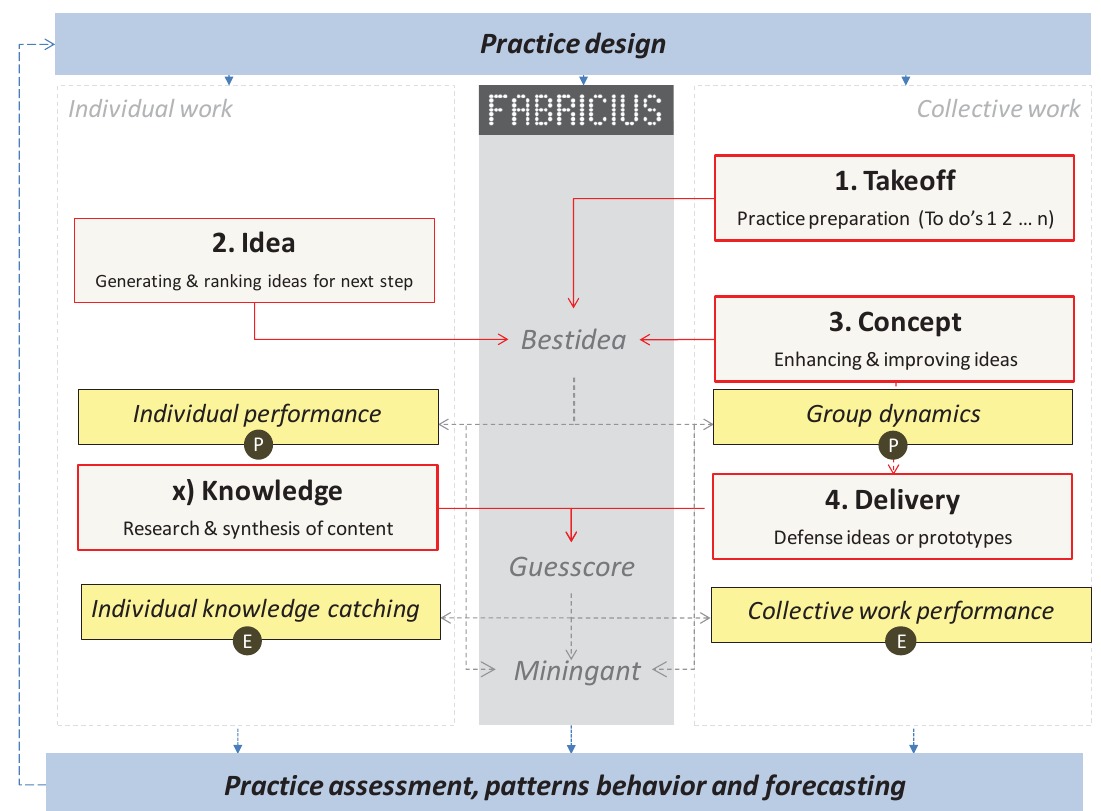
Figure 1 . General view and components of teaching model Table 2. Main elements of